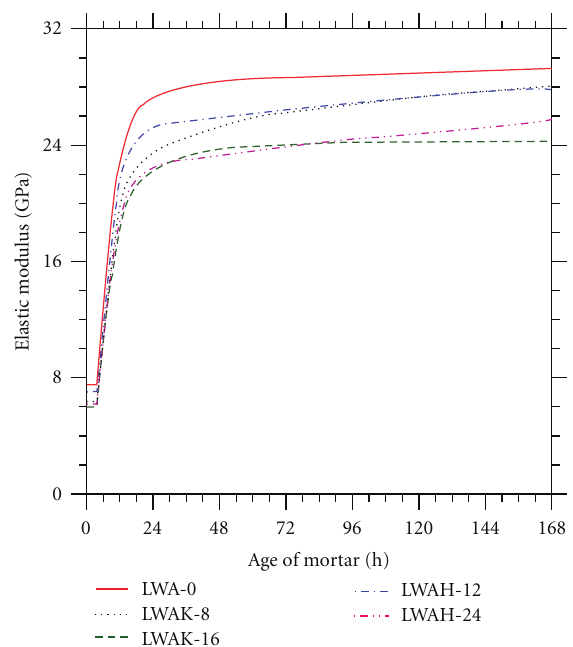
Figure 2: Elastic modulus development of mortar mixtures (fitted)